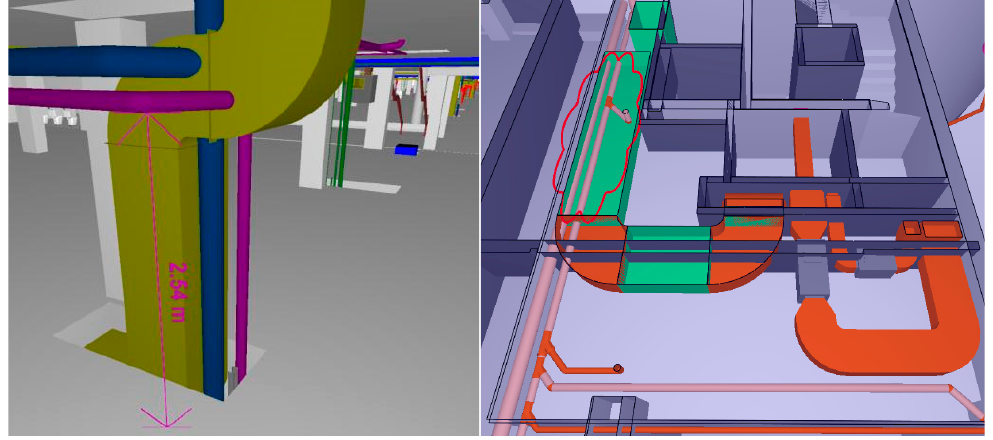
Figure 5. Virtual representation of collisions between ventilation ducts and plumbing pipeline at different height ( left ) and parallel collision ( right ). BIM Model.